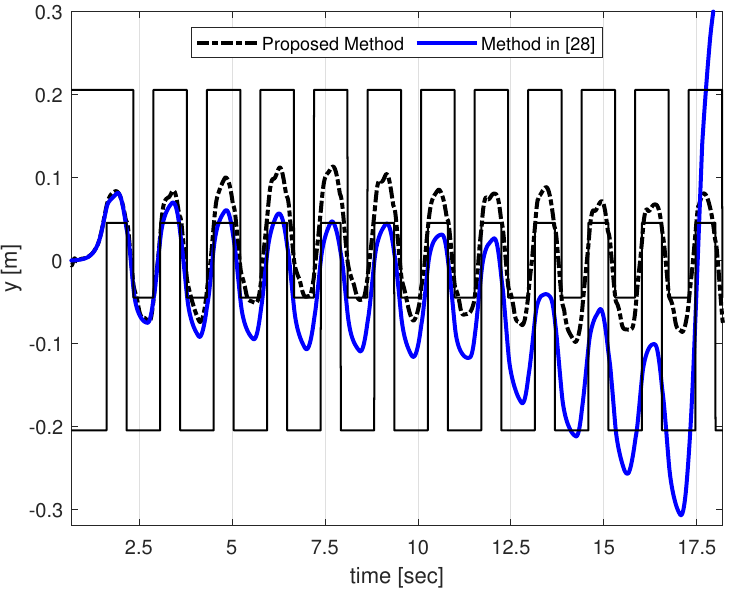
Figure 10. ZMP trajectories for BRZ-5 with two